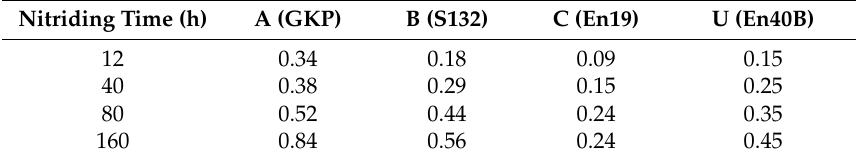
Table 3. Case depths (mm) of the studied samples.